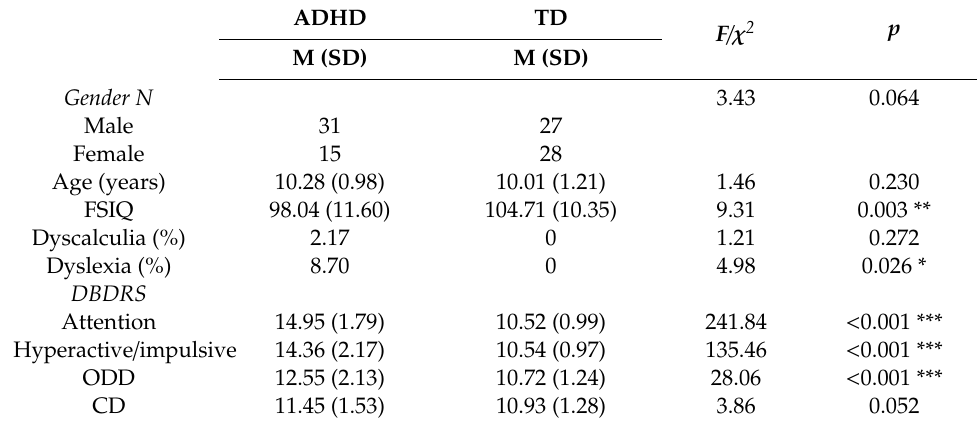
Table 1. Demographic and Clinical Characteristics of Children in the ADHD and TD